Question: What kind of plot is shown here?
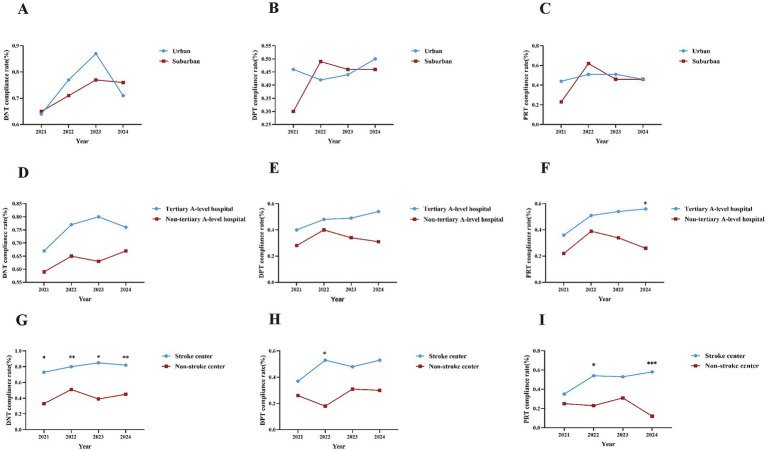
Answer: line